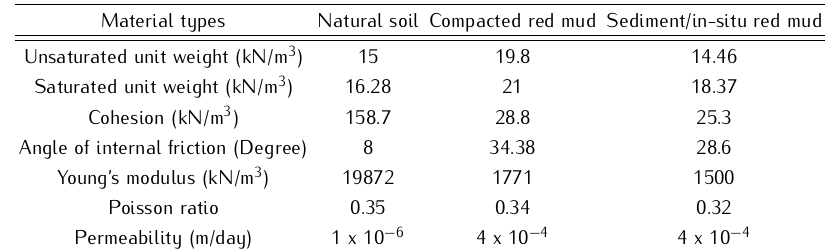
Table 2. Parameters of the Mohr-Coulomb model Material